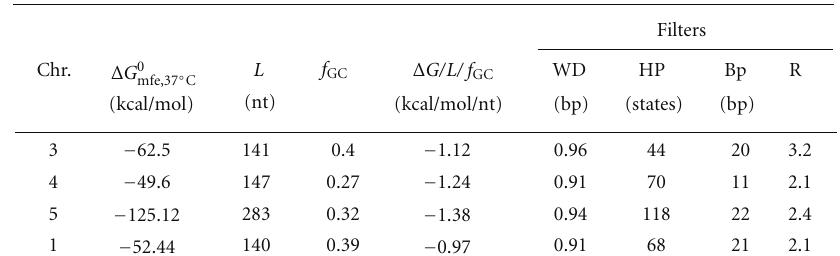
Figure 3: Secondary structure and features of sequences classified by novoMIR as pre-miRNAs. Positions in the A. thaliana chromosomes is given above the structures. The predicted miRNA/miRNA ∗ complexes are shown in larger italic characters. The table contains features of the sequences and their structures; the filter values are fraction of base pairs in five windows (with default threshold t WD = 0 . 65), stem-loop length ( t HP = 30), maximal helix length ( t BP = 8), ratio of sequence and stem length ( t R = 6). For expression pattern of small RNAs at the genomic location of these sequences, see supplemental Figures